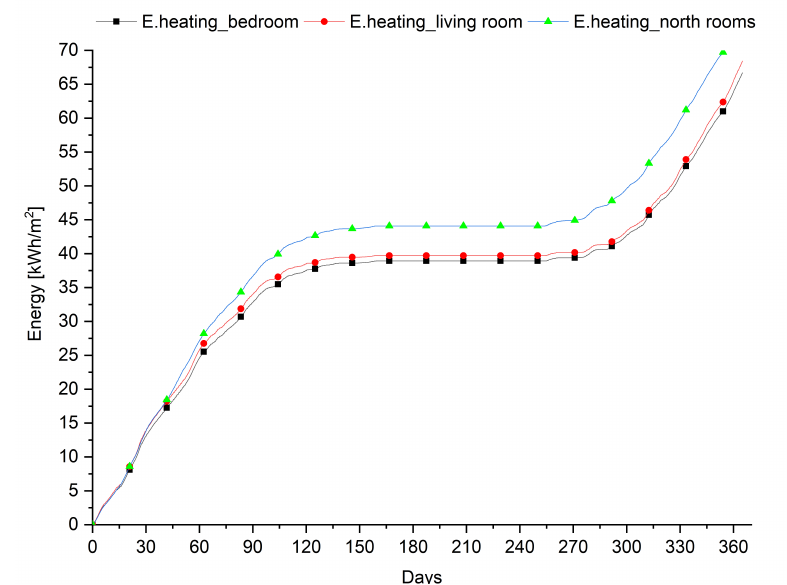
Figure 8. Duration curve of heating energy inside the bedroom, living room and north-facing